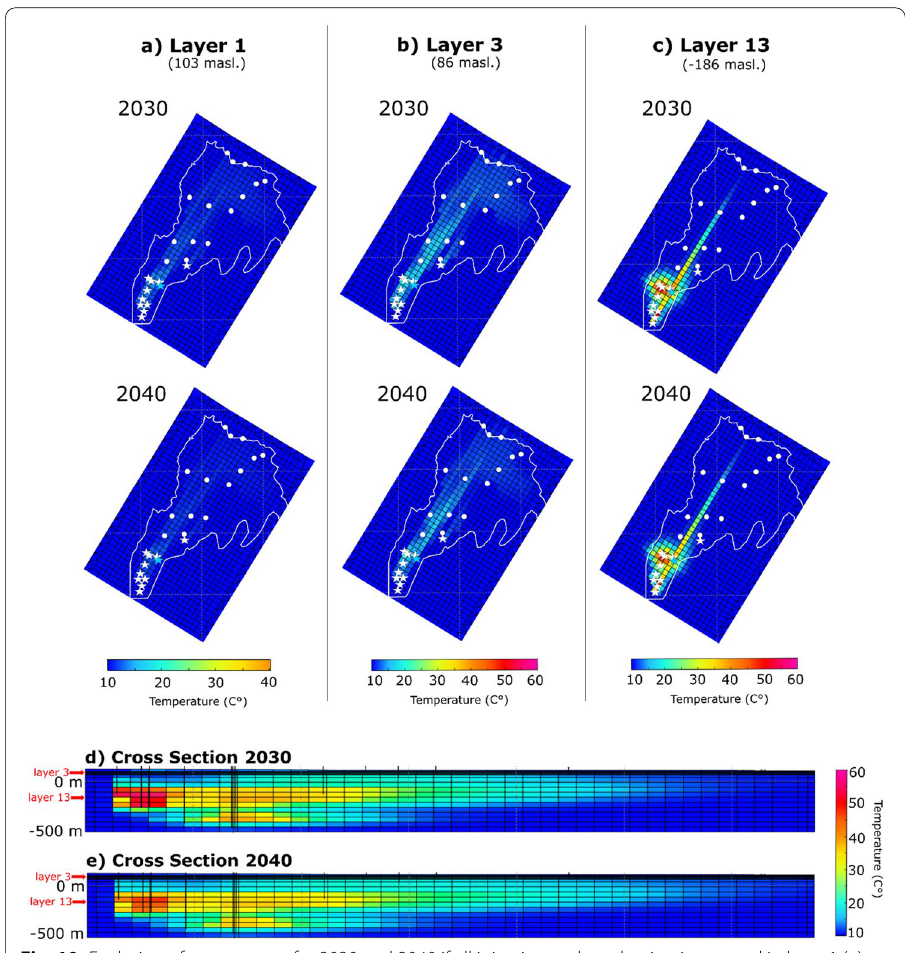
Fig. 19 Evolution of temperature for 2030 and 2040 if all injection and production is stopped in layer 1 ( a ), layer 3 ( b ) and layer 13 ( c ). Cross section shows temperature distribution along the most permeable fault (FAU10) for 2030 ( d ) and 2040 ( e